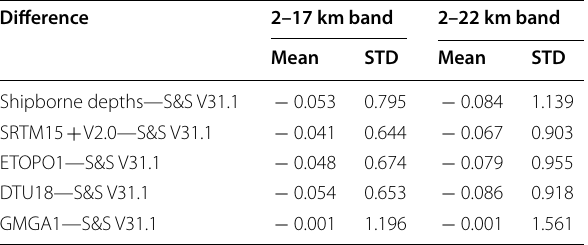
Table 12 Accuracy statistics of short wavelength gravity